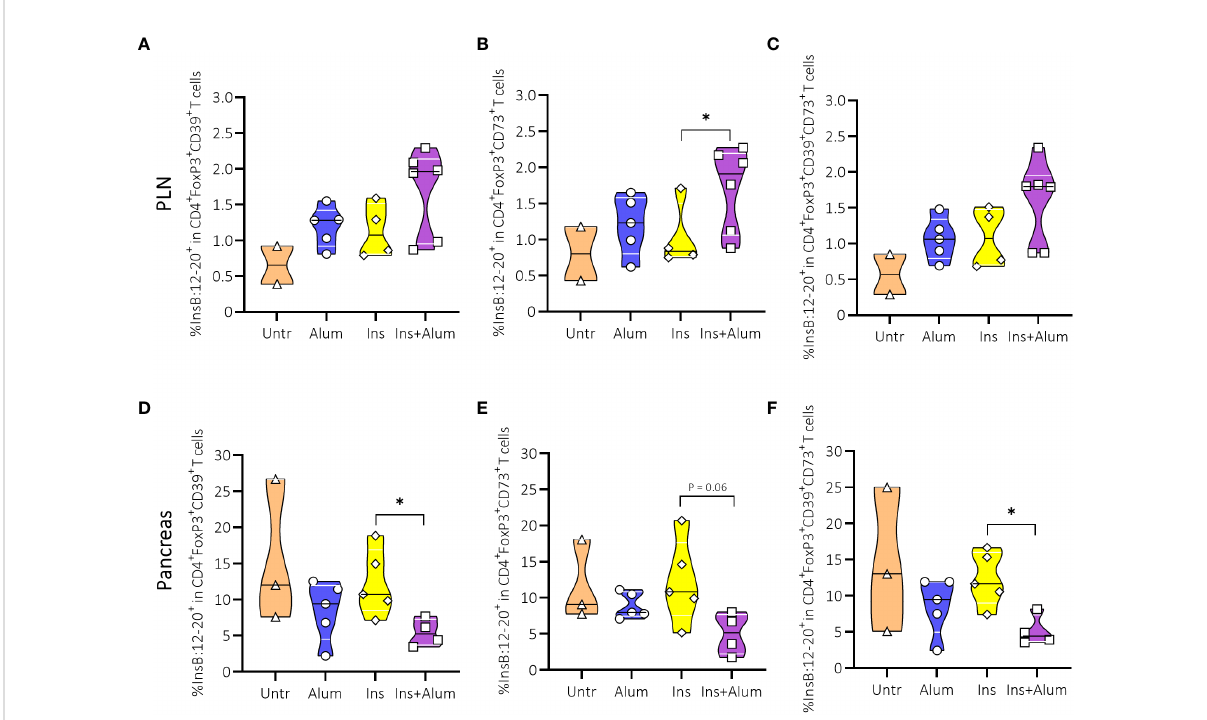
FIGURE 6 Effect of insulin therapy on InsB:12-20-reactive CD39- and/or CD73-expressing FoxP3 + Tregs. Frequencies of InsB:12-20-reactive cells within the CD4 + FoxP3 + CD39 + T cell population (A, D) , CD4 + FoxP3 + CD73 + T cell population (B, E) , and CD4 + FoxP3 + CD39 + CD73 + T cell population (C, F) are shown at 15 weeks of age in PLN and/or pancreas of NOD mice. Female NOD mice received four weekly subcutaneous injections, from 10 until 13 weeks of age, of InsB:8-24 peptide formulated in alum (Ins+alum), InsB:8-24 peptide dissolved in buffer (Ins), alum alone (alum), or left untreated (Untr). Data presented as median with interquartile range; symbols (n = 2-6) represent individual mice. *P ≤ 0.05; Treg, regulatory T cell; NOD, non-obese diabetic; PLN, pancreas-draining lymph